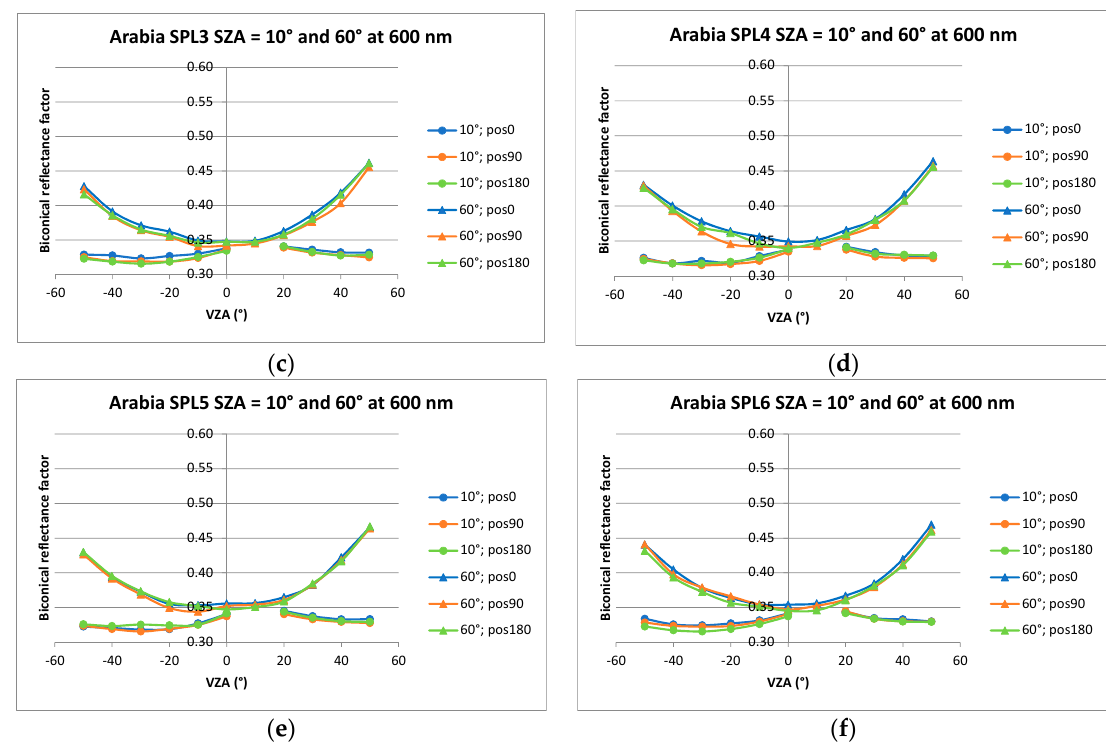
Figure 12. BCRF for the minimum (10°) and the maximum (60°) solar zenith angles, in the principal plane, for Arabian samples: ( a ) sample 1; ( b ) sample 2; ( c ) sample 3; ( d ) sample 4; ( e ) sample 5; ( f ) sample 6.